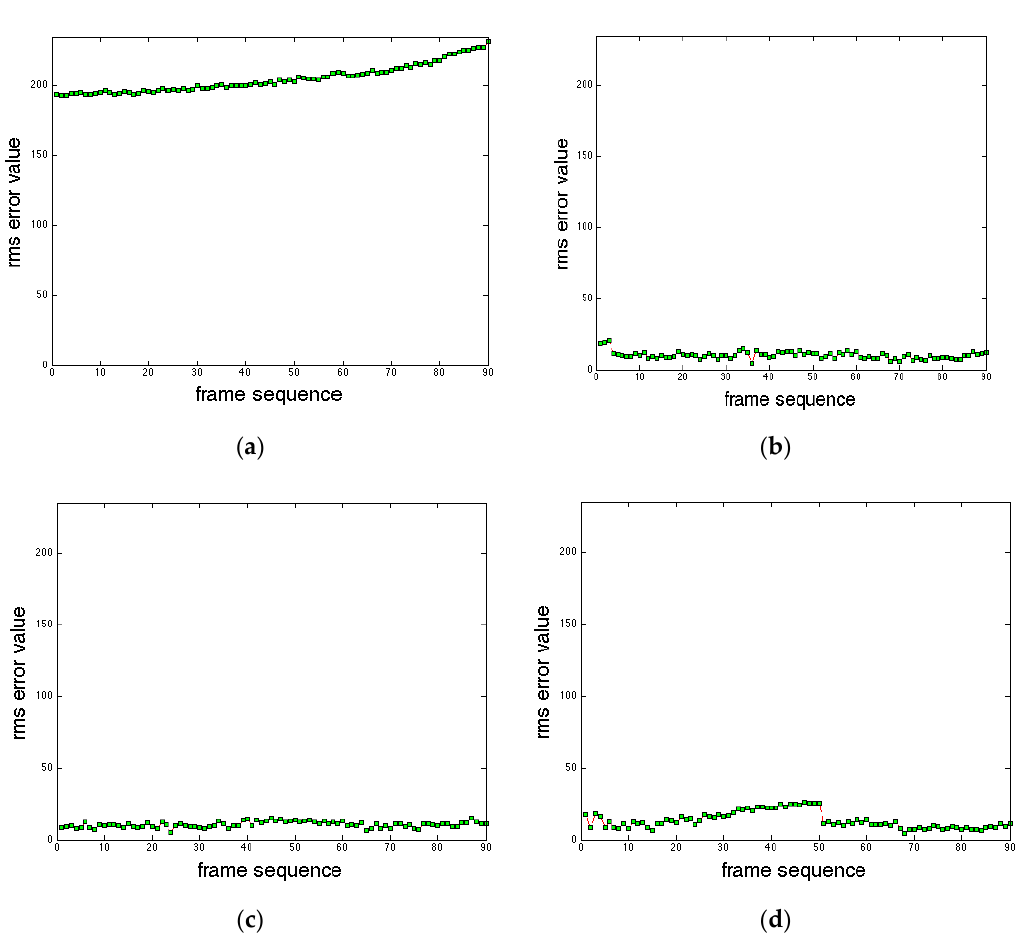
Figure 10. Corner and horizon registration rms errors. ( a ) Original data set with no registration; ( b ) original data set with registration; ( c ) data set with intermediate turbulence; and ( d ) data set with severe turbulence.